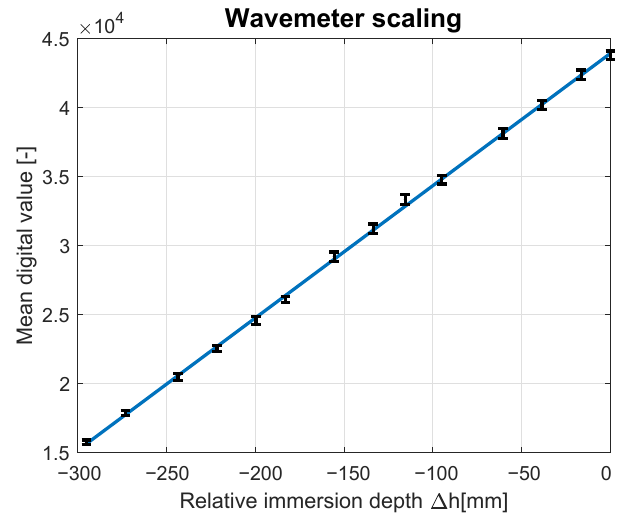
Figure 3. Wavemeter characteristics verification and